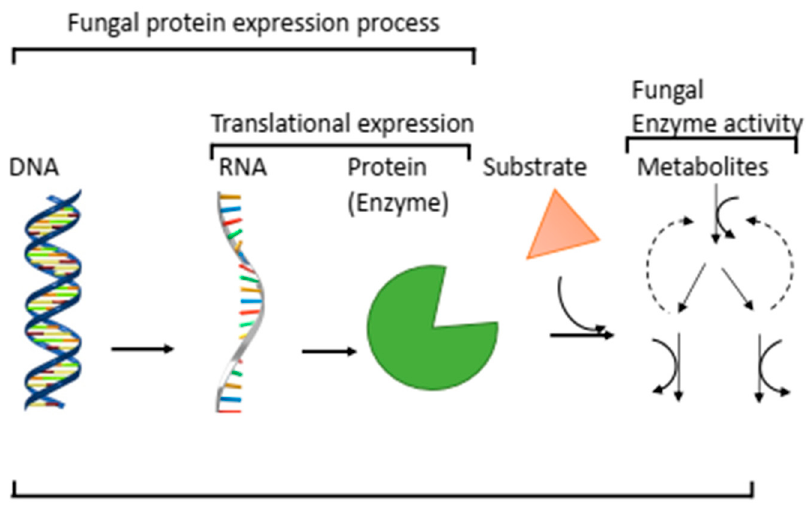
Figure 1. Fungal protein (enzyme) expression